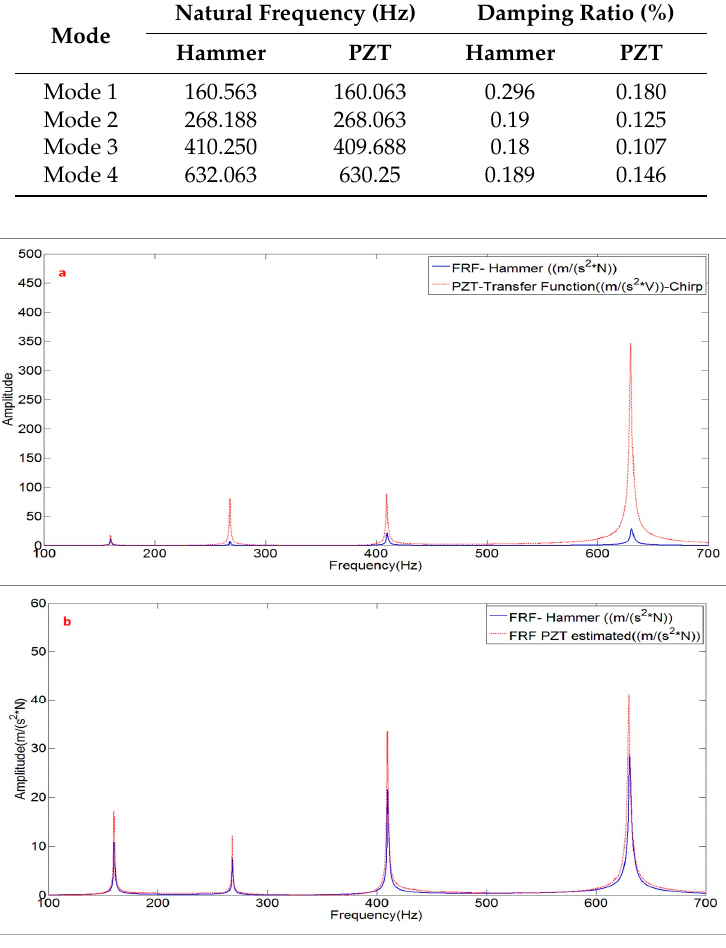
Figure 17. ( a ) Comparison PZT transfer function with FRF; and ( b ) comparison FRF estimated with the PZT and FRF obtained with the Hammer. The Structure is close to a rigid wall.